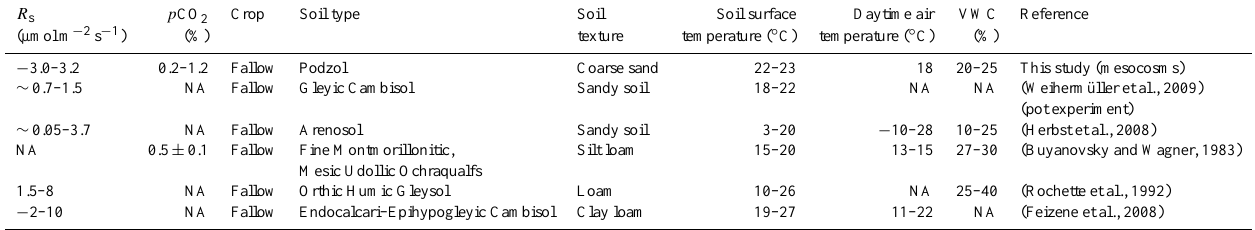
Table 2. Ranges of soil respiration ( R s ) and soil partial pressure of CO 2 ( p CO 2 ) in unplanted mesocosms as compared to other studies (one in pots, four in the field). NA represents not available, VWC represents volumetric water content.